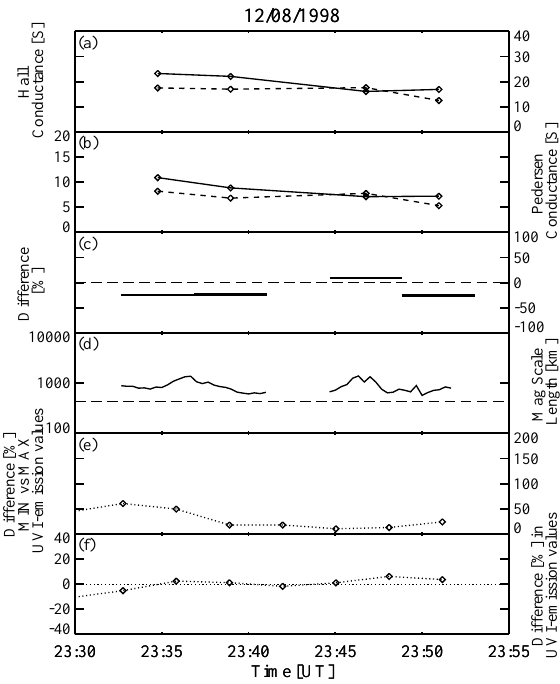
Fig. 9. ( a ) The Hall and ( b ) Pedersen conductances [S] derived in the Scandinavian region using UVI and PIXIE measurements (solid line) and the 1-D method of characteristics (dashed line) on 12 Au- gust 1998. ( c ) The difference in % between the two conductance sets. The horizontal dashed line is drawn to give the 0-percent level, while the length of the lines indicates the integration time period. ( d ) Magnetic field scale lengths (km) between the two MIRACLE magnetometer stations of AND and KEV. ( e ) The average percent- age calculated using the lowest and largest UVI-LBHL emission values at four strips of constant latitude within the STARE FOV. ( f ) The difference in % for the average UVI-LBHL intensity within the STARE FOV compared with the average UVI-LBHL intensity when including a larger area surrounding the STARE FOV match- ing the PIXIE resolution.